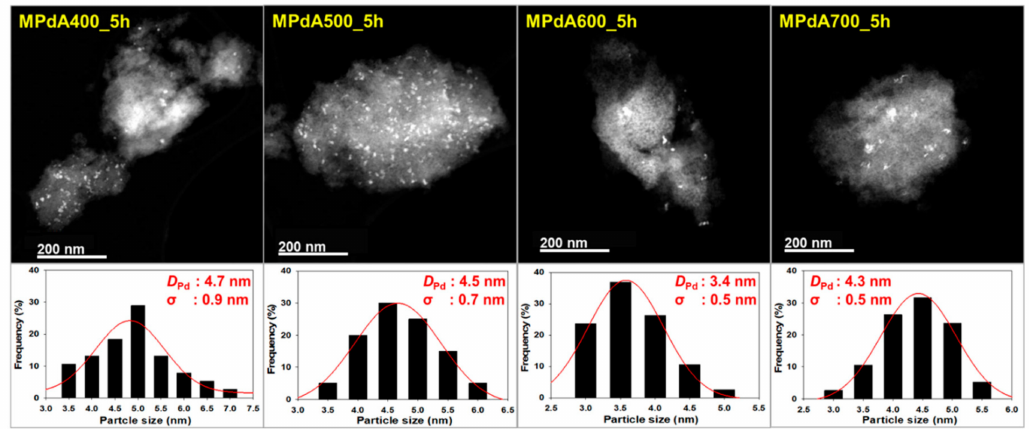
Figure 2. HAADF-STEM images and particle size distributions of the reduced MPdA catalysts calcined at di ff erent temperatures for 5 h ( D Pd : Pd mean size, σ : standard